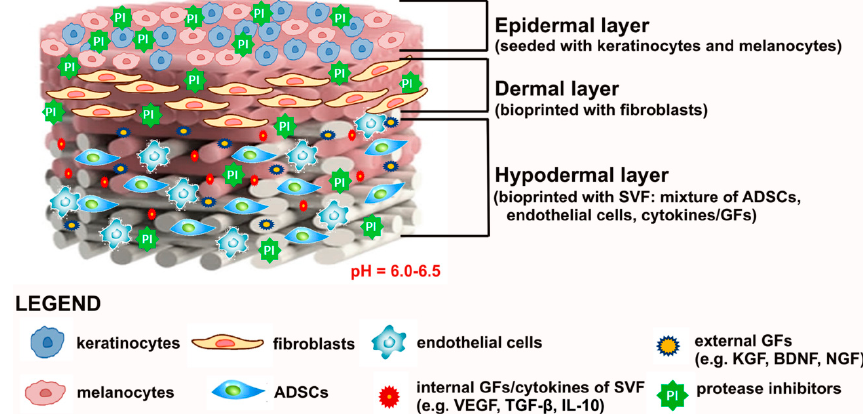
Figure 7. Graphical representation of the potentially ideal artificial skin graft.